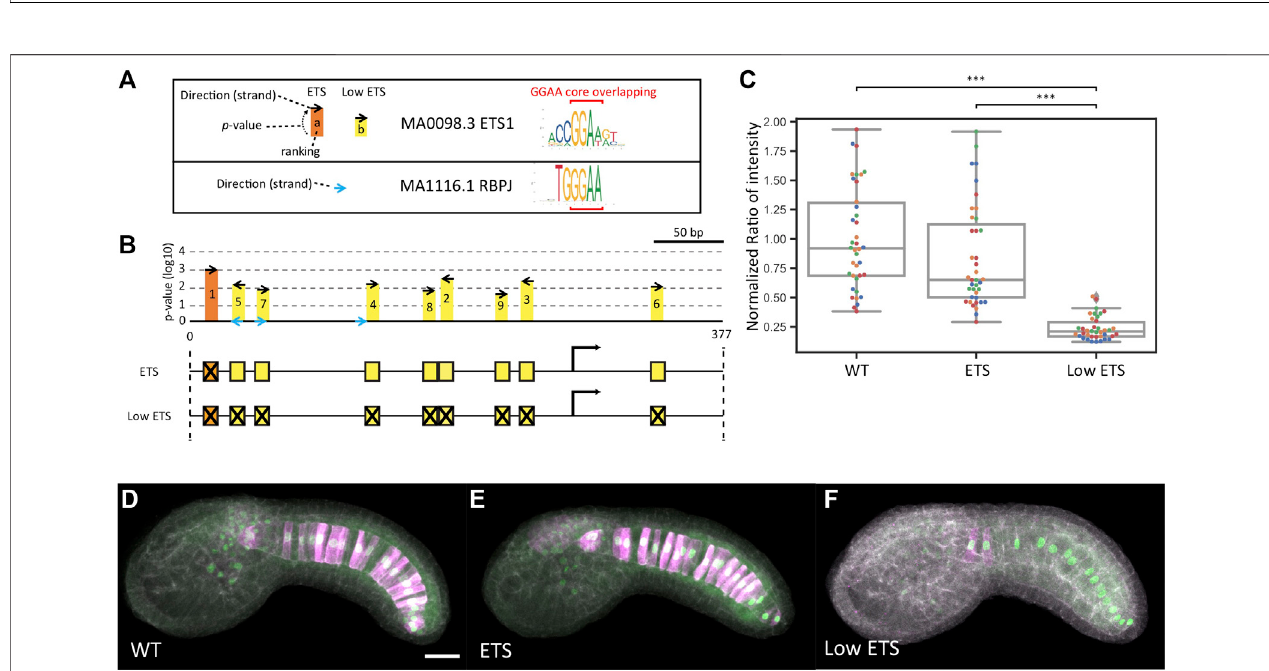
FIGURE 4 | Analysis of low scoring ETS sites. (A) Sequence logos for the ETS and RBPJ Position Weight Matrices used in this study with the overlapping GGAA core indicated with red brackets. On the left is a key for the symbols used in the map in B). (B) Map of the bra proximal promoter/enhancer region showing the high scoring ETS site mutated in the initial ETS construct (orange) and 8 additional lower scoring sites mutated in the Low ETS construct (yellow) Putative RBPJ sites are shown in blue. (C) Normalized reporter expression for the ETS construct versus the Low ETS construct. Each datapoint represents a different imaged embryo. Each color indicates embryos from the same replicate. The box plots indicate the outlier-adjusted minimum, 1st quartile, median, 3rd quartile and outlier-adjusted maximum for each construct. Outliers are marked as lozenges. Asterisks indicate differential reporter expression between the mutant construct and the wildtype construct. *** p < 0.001. (D – F) Representative sum-projected confocal images. (D) , wild type. (E) , ETS. (F) , Low ETS. Magenta: YFP reporter expression. Green: Bra > H2B:HA internal control expression. Gray: phalloidin. Scale bar, 20 µm.